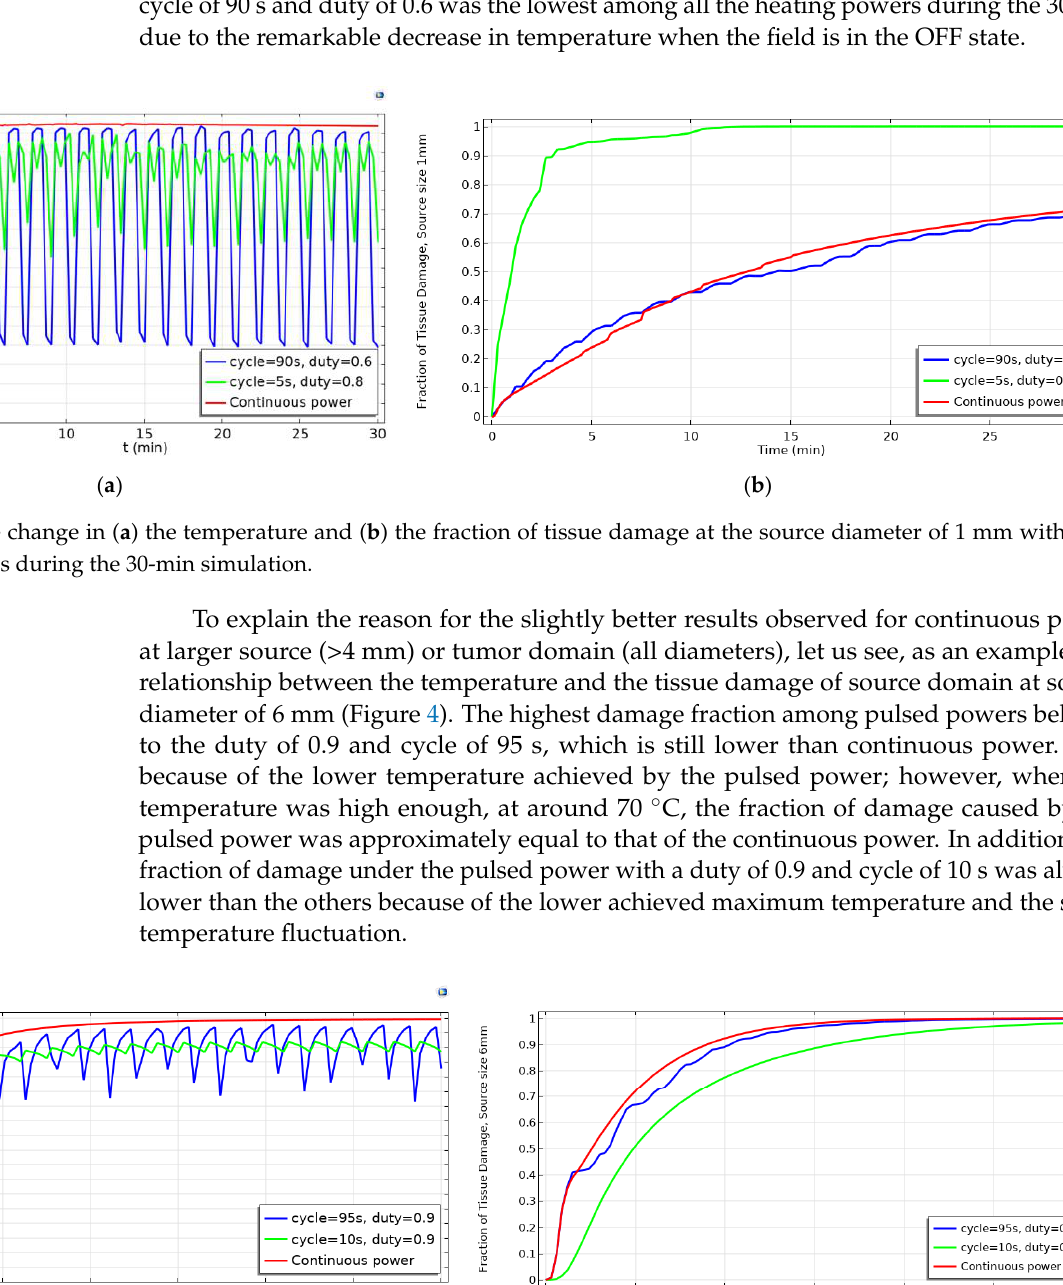
( b ) Figure 5. T he temperature at ( a ) tumor domain and ( b ) tumor neighboring domain with source diameter of 6 mm during the 30-min simulation. 3. Discussion According to our observations, the pulsed powers achieved either higher or almost the same fractions of damage as the continuous power for all diameters under the same inputs at the source (see Table 2). However, it may be more efficient to utilize pulsed pow- ers for small diameter breast tumors (not larger than 4 mm) because of requiring a smaller heating power and a simpler magnetic field generation system. In addition, using pulsed powers for damaging the entire tumor leads to reducing the side effect of the eddy current to the surrounding heathy tissue for all conditions compared to continuous power—the method that is currently employed in typical magnetic hyperthermia therapy. It means that pulsed power can be a suitable choice for treating small breast tumors in terms of reducing the necessary heating power (the heating efficiency of the MNPs plus the applied magnetic field) and minimizing the side effects to the healthy tissues. It should, however, be noted that since the side effects of the pulsed powers are also less for larger source diameters, if a proper magnetic field generation system can be designed, utilizing the pulsed powers would be again more beneficial as compared to continuous power. However, designing a system to apply a high pulsed power for human scale will be very challenging. One possible solution to apply the pulsed powers for magnetic hyper- thermia can be the use of a combined magnetic particle imaging and magnetic hyperther- mia system [34,35]. In this type of approach, MNPs can be injected into the region of in- terest (the entire tumor), which is aimed to be treated. The heating system can generate and move a field free region (FFR) at the targeted domain and only the MNPs located in